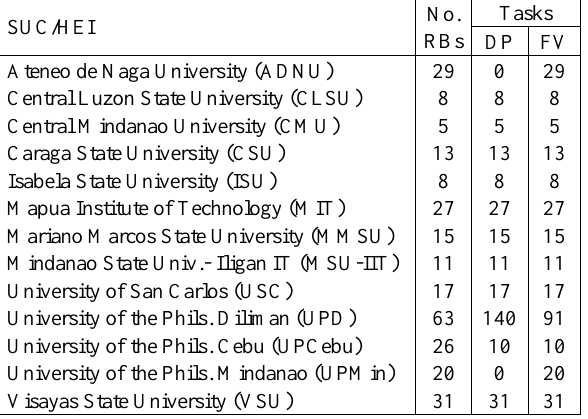
Table 1. List of SUCs/HEIs, number of RBs, and PHD tasks Since the project involves inventory and mapping of water resources in a national scope, it was divided into three (3) sub- components based on the nature of the features. The subcomponents of PHD are: (1) delineation of stream channels; (2) extraction of inland wetlands; and (3) compilation and extraction of irrigation networks. The sub-components are focused on the mapping of different hydrologic units from RS images using combinations of different RS and GIS methods.